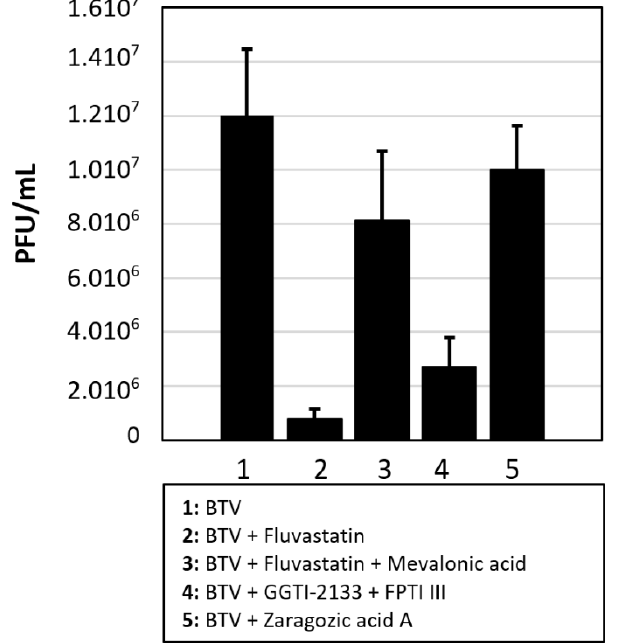
Figure 7. Effects of fluvastatin, mevalonate pathway inhibitors and components on BTV replication in KC cells. BTV-8 virus titres (PFU/mL) generated by infected KC cells treated with fluvastatin, inhibitors of geranylgeranylation (geranyl-geranyl transferase inhibitor GGTI-2133 and farnesyl pyrophosphate transferase inhibitor FTPIII), or inhibitors of squalene synthase (zaragozic acid A). Some cells were treated with fluvastatin then supplemented with mevalonic acid in attempts restore virus replication. These results are representative of three independent experiments. Error bars with standard deviations are shown.